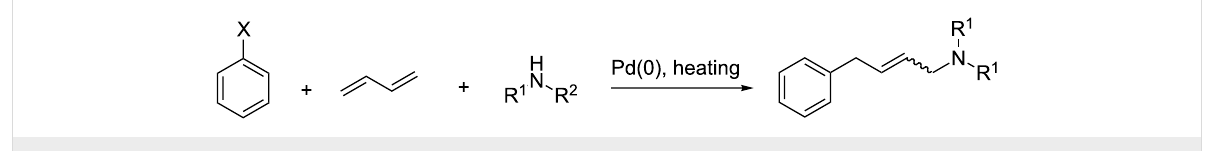
Scheme 38: The three-component carbopalladation of dienes on the example of buta-1,3-diene.